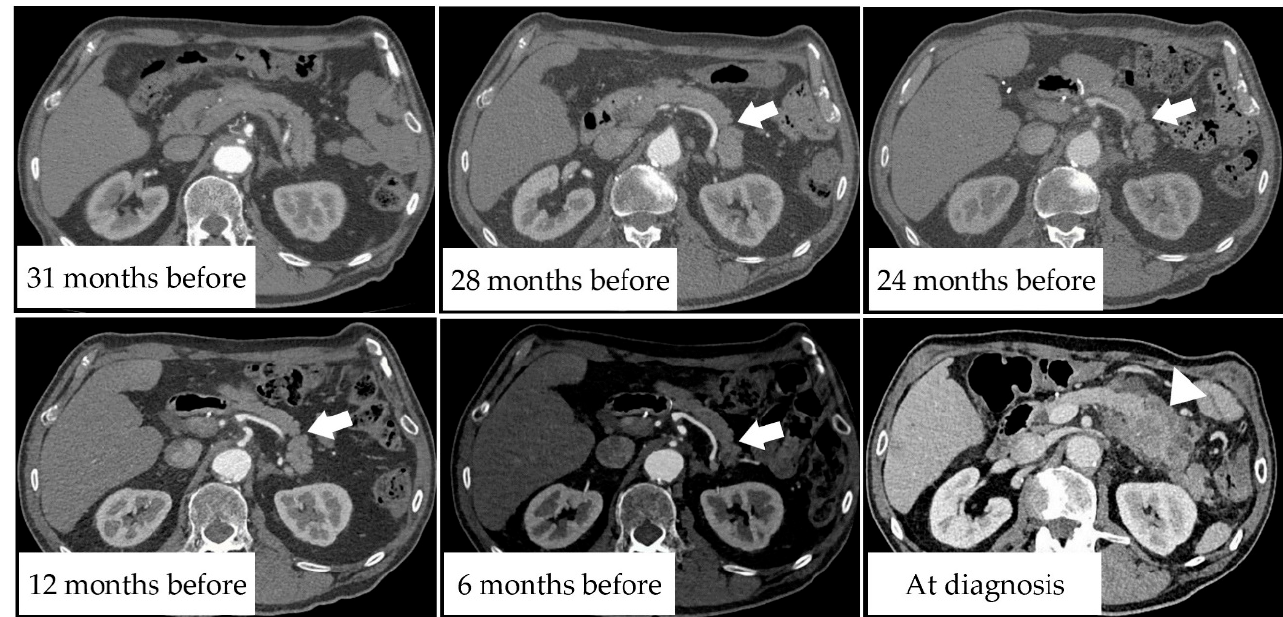
Figure 1. A man in his late 70 s with pancreatic tail ductal adenocarcinoma. Pre-diagnostic CT scans at 31, 28, 24, 12, and 6 months before PDAC diagnosis showing temporal changes in the pancreatic tail. White arrows indicate focal pancreatic atrophy, and the white arrowhead indicates invasive pancreatic ductal adenocarcinoma.